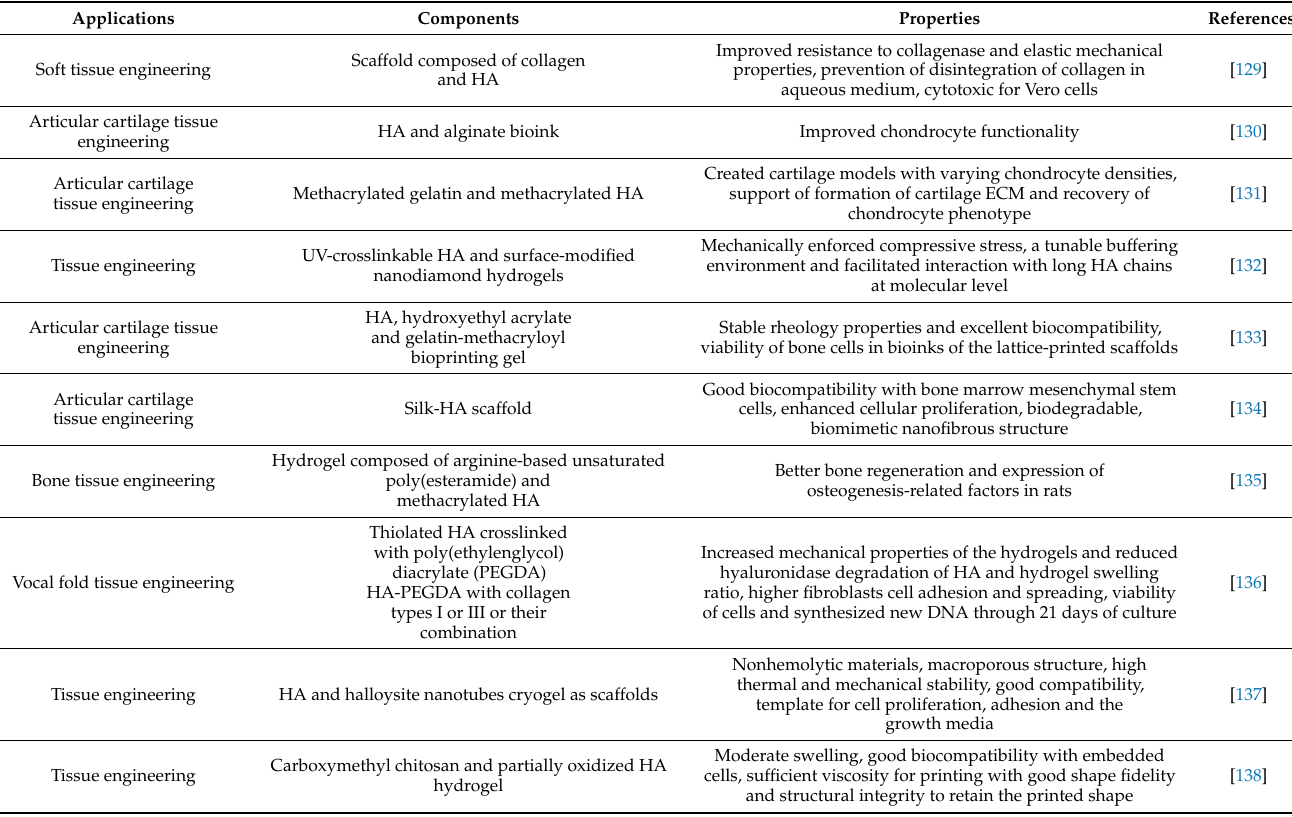
Table 2. Summary of using HA with other components in engineering of various